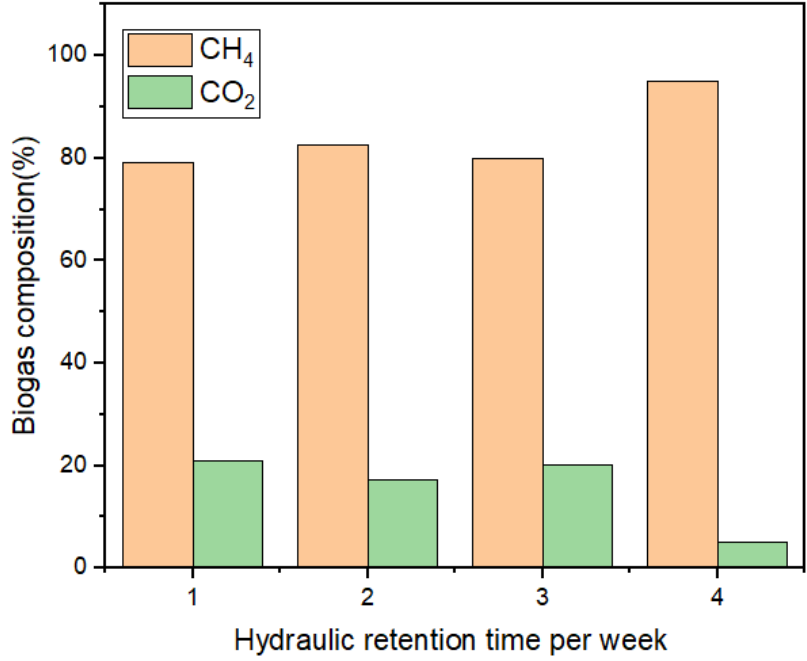
Figure 4. Weekly biogas composition of the BP system.